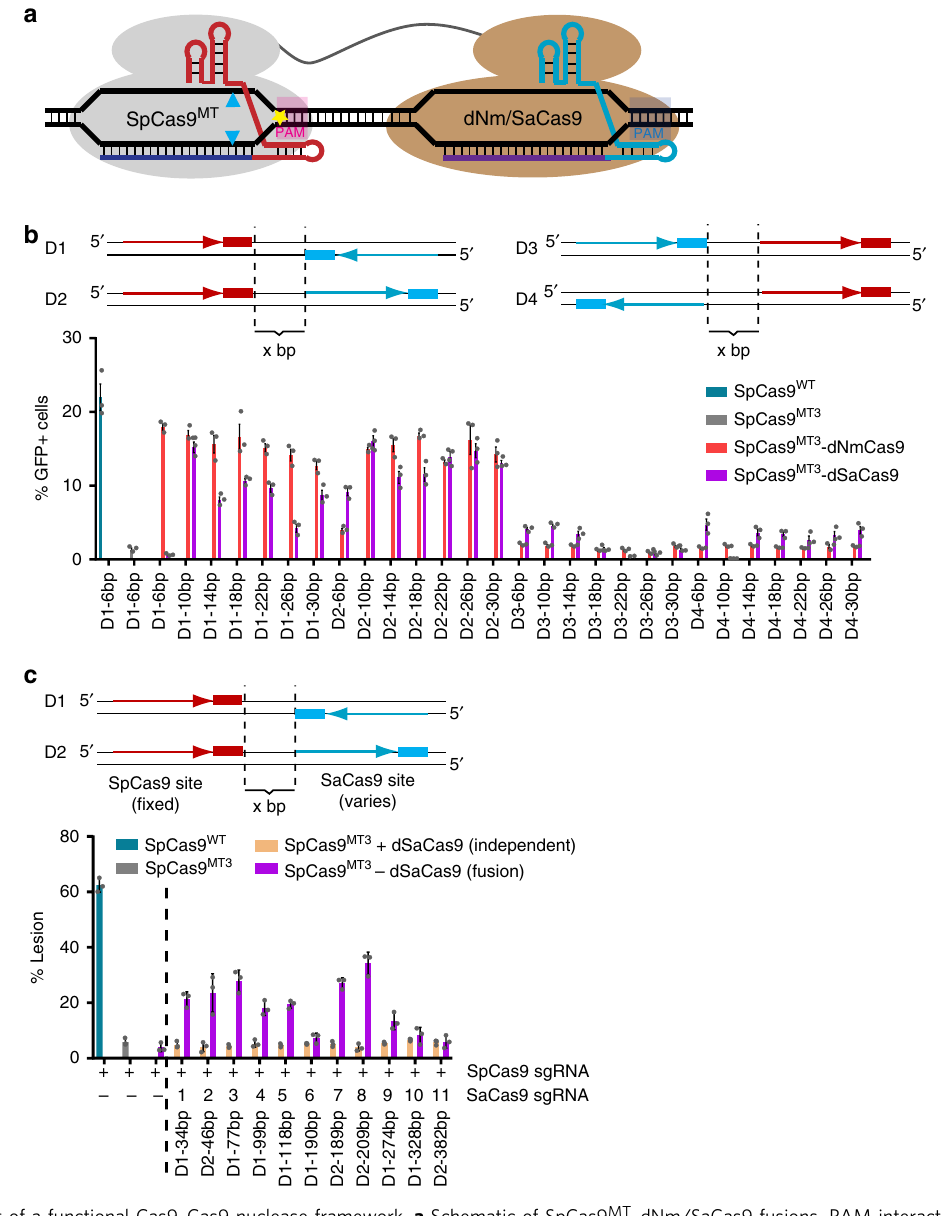
Fig. 1 Development of a functional Cas9 – Cas9 nuclease framework. a Schematic of SpCas9 MT – dNm/SaCas9 fusions. PAM-interaction attenuated SpCas9 15 (yellow star) is C-terminally fused to a nuclease-dead Cas9 from N. meningiditis or S. aureus . Each Cas9 is loaded with its cognate sgRNA. b Top, schematic of parameters tested for target site organization. Four composite target site con fi gurations are tested (D1:D4). The red arrow and rectangle represent the SpCas9 protospacer (in 5 ′ – 3 ′ orientation) and PAM, respectively, whereas the blue arrow and rectangle represent the Nm/SaCas9 protospacer (in 5 ′ – 3 ′ orientation) and PAM, respectively. Two dashed lines indicate the edges of each orthogonal Cas9-binding site, and x represents the number of intervening nucleotides. Bottom, activity pro fi les of SpCas9 (blue), SpCas9 MT3 (R1335K; gray), and C-terminal fusions for SpCas9 MT3 – dNmCas9 (pink), and SpCas9 MT3 -dSaCas9 (purple) in the GFP reporter assay. GFP reporter assay data are from three independent biological replicates performed on different days in HEK293T cells. c Changes in the activity pro fi le of SpCas9 MT3 -dSaCas9 nuclease as a function of the distance between sgRNA-binding sites at the AAVS1 locus. Top, schematic of the orientation of the target sites, where the SpCas9 site is fi xed and the SaCas9 site is shifted away various distances to examine its distance-dependent activity (Supplementary Fig. 2) Bottom, deep sequencing data are from three independent biological replicates performed on different days in HEK293T cells, where the orientation and spacing between the orthogonal Cas9 sites is indicated below the x -axis (Supplementary Data 1). Error bars indicate ±